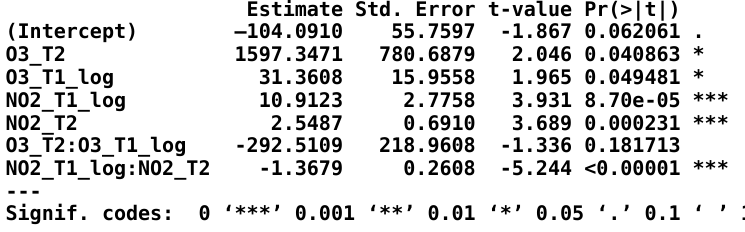
Figure 7 . Testing for Interaction Figure 7. Testing for